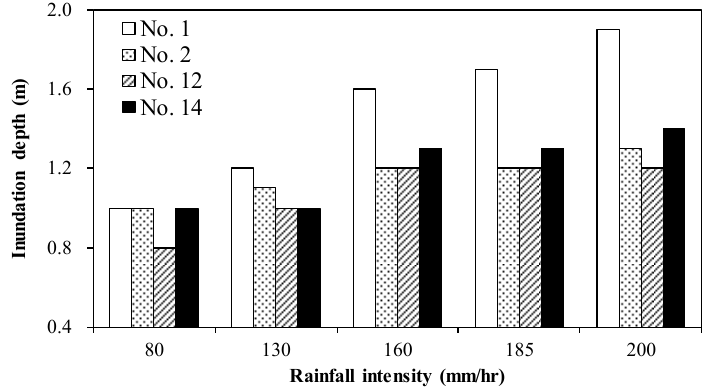
Figure 9. Inundation depth near the subway station entrance.